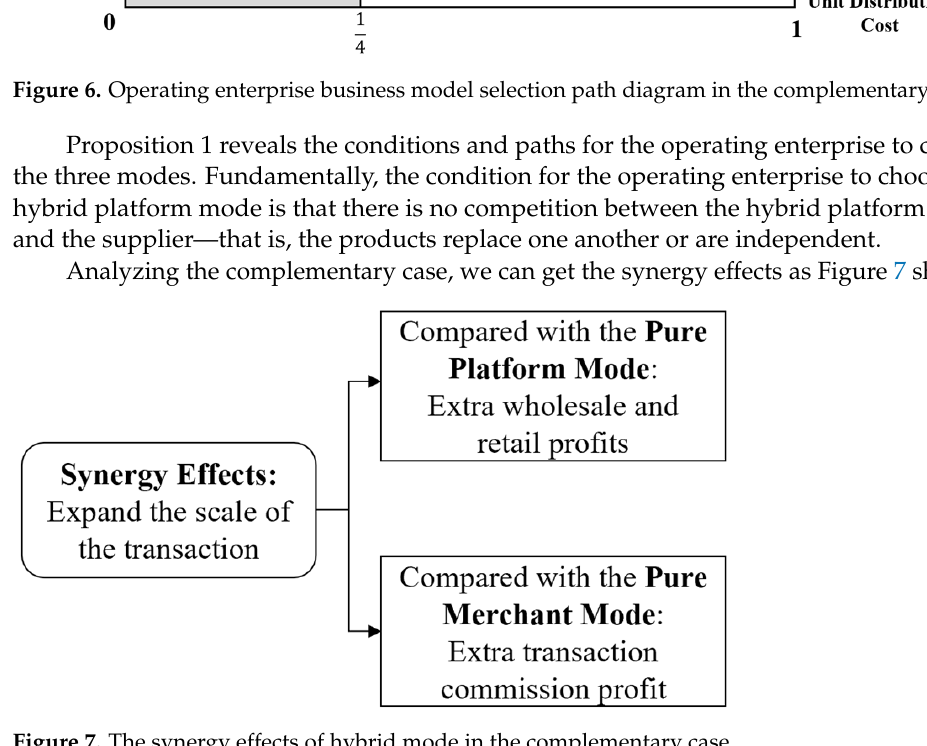
Figure 7. The synergy effects of hybrid mode in the complementary case.